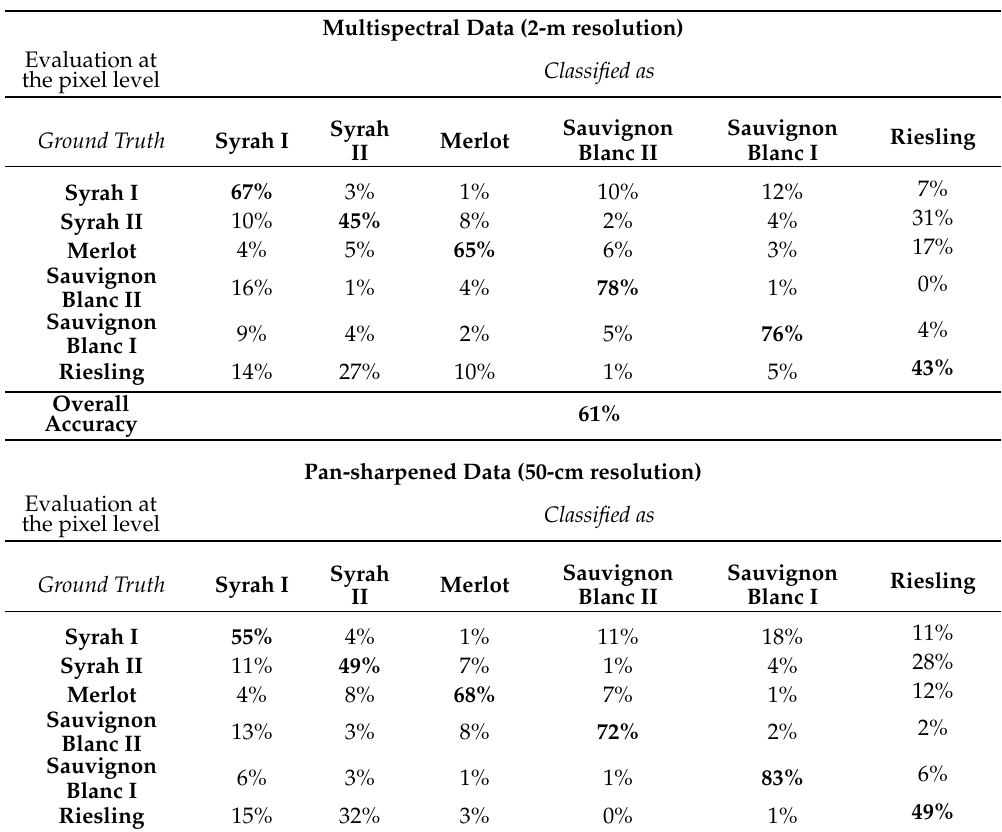
Table 5. The resulting confusion matrices for the vine variety discrimination between six different vine varieties/clones in the Trapeza study